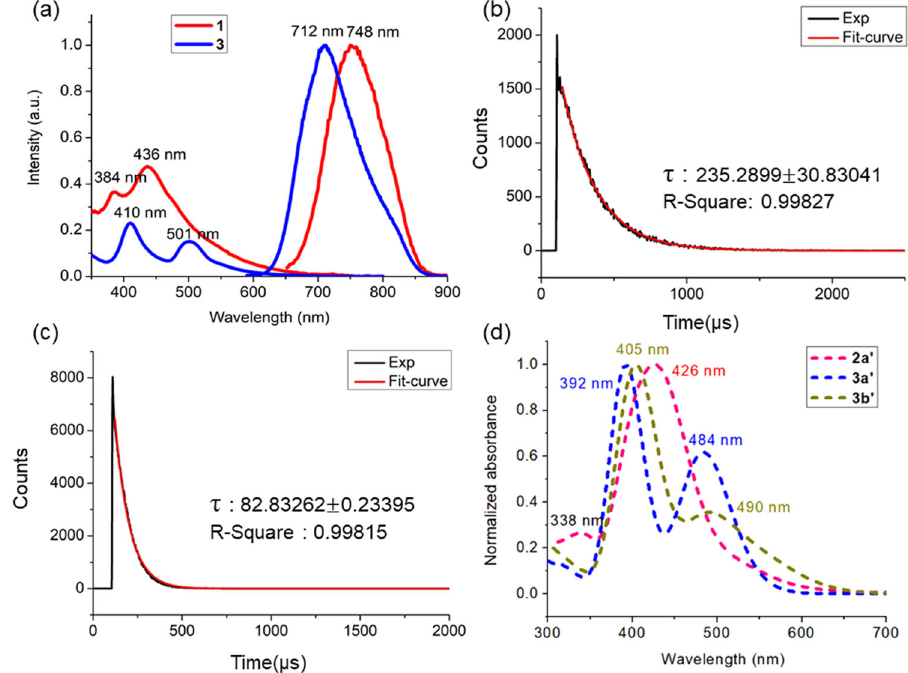
Fig. 8 Experimental and theoretical photophysical studies of title clusters. a UV – vis spectrum of 1 , and 3 in 1 ×10 − 5 M CH 2 Cl 2 (left) and emission spectrum of 1 and 3 in MeTHF at 77 K (right). b , c Time-resolved photoluminescence spectrum of 2 a and 3 at 77 K. d The TD-DFT-simulated UV – vis spectrum of 2a ’ , 3a ’ and 3b ’